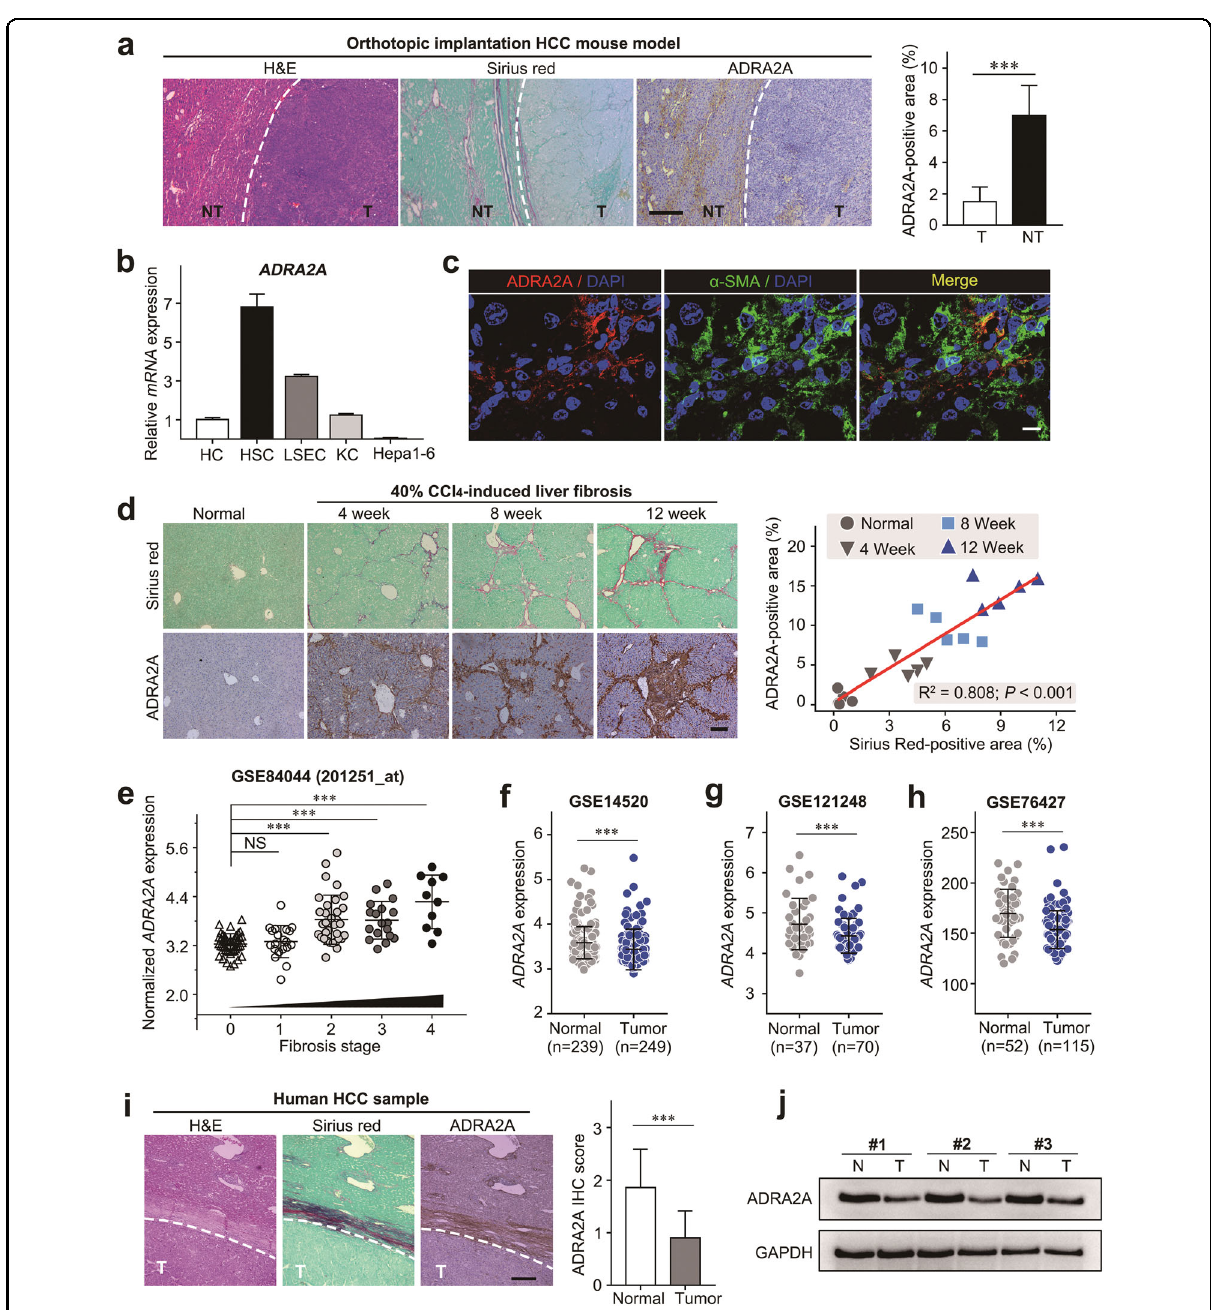
Fig. 2 ADRA2A was mainly expressed in aHSCs but was barely detected in HCC cells. a H&E, Sirius red, and ADRA2A IHC were performed in mouse orthotopic HCC tissue. Representative images (left panel) and statistical analysis of ADRA2A IHC (right panel) are shown; T tumor, NT nontumor; scale bars, 100 μ m. b The ADRA2A mRNA level in mouse primary hepatic cells (HC hepatocyte, KC Kupffer cell, LSEC, liver sinus endothelial cell, HSC hepatic stellate cell) and mouse HCC cell (Hepa1 – 6). c Double immuno fl uorescence staining of ADRA2A and α -SMA in mouse fi brotic tissue. Scale bars, 10 µm. d Representative Sirius red image and ADRA2A IHC image of mouse normal liver and progressively fi brotic liver (left panel). Correlation between ADRA2A IHC staining and Sirius red staining (right panel); scale bars, 100 μ m. e The publicly available database from the National Cancer for Biotechnology Information Gene Expression Omnibus (GSE84044) was used to explore the role of ADRA2A in liver fi brosis/cirrhosis. f , g ADRA2A expression was investigated in public datasets: GSE14520, GSE121248, and GSE76427. i H&E, Sirius red, and ADRA2A IHC were performed in HCC patient tissue, and the representative images are shown; T tumor; scale bars, 100 μ m (left panel), the statistical analysis of ADRA2A expression in HCC tissues and their adjacent normal tissues (right panel). j ADRA2A expression was detected by western blotting. Data are presented as the mean ± SD. *** P <